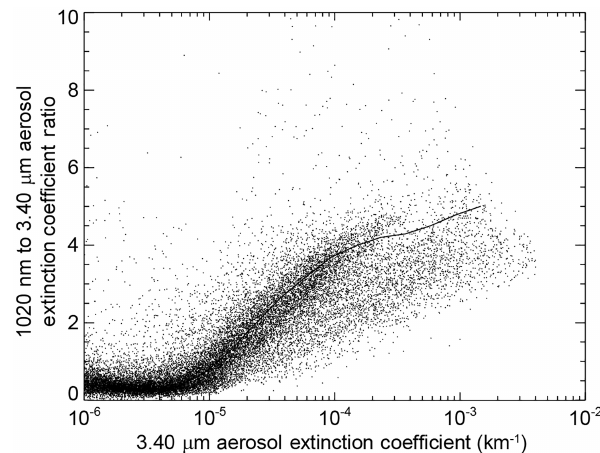
Figure 7. Relationship between corrected HALOE 3.40µm aerosol extinction coefficient and the observed gridded and cloud-cleared SAGE II observations at 1020nm. The solid line is the empirical conversion used to infer 1020nm aerosol extinction coefficient from HALOE observations at 3.40µm.